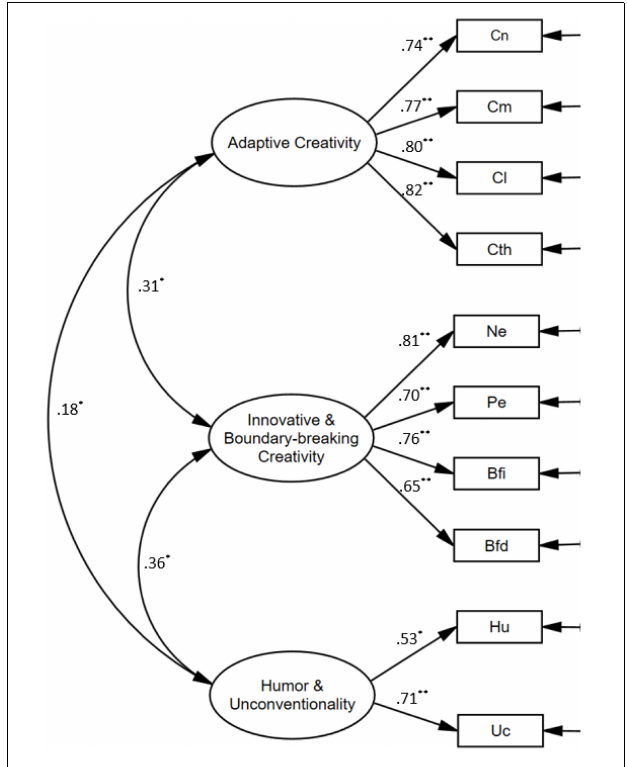
FIGURE 2 | The factor structure, standardized regression weights, and correlation coefficients of the TCT–DP; * p < 0.05; ** p < 0.01.